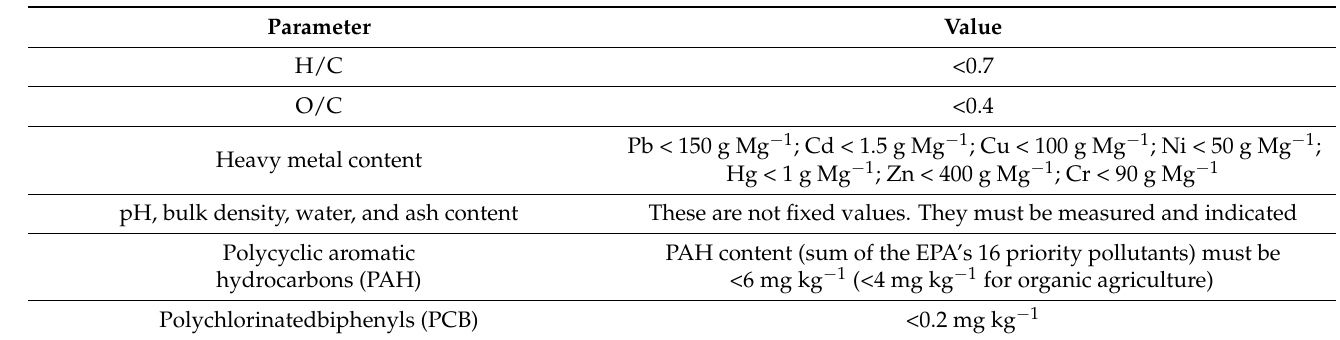
Table 2. Technical parameters for biochars established by the European Biochar Certificate. The list is incomplete. It is, however, available in the link reported in Reference